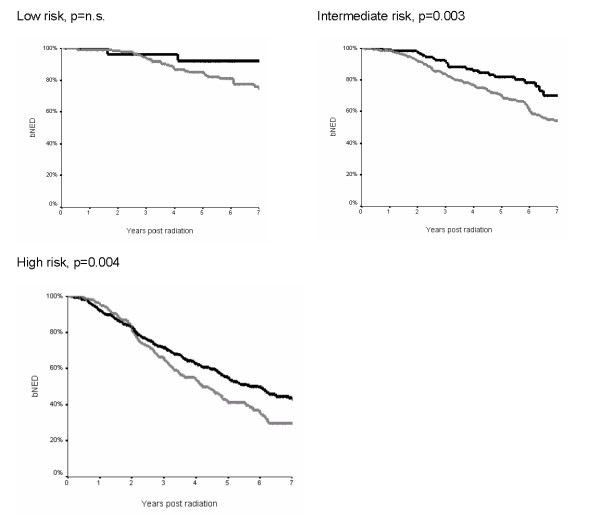
Kaplan Meier curve for bNED (biochemical lack of evidence of disease survival) according to NCCN risk groups [3]. Black lines show combined EBRT and ADT, grey lines EBRT alone. P values refer to the log-rank test.